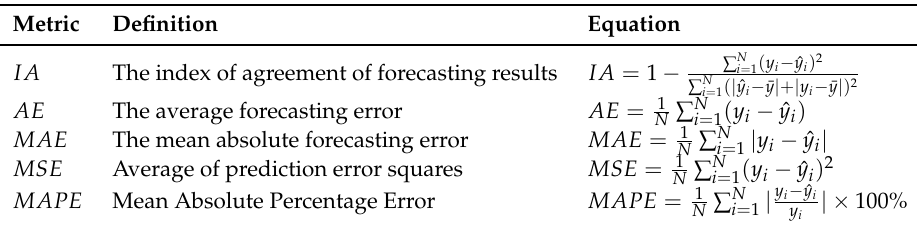
Table 2. Five error